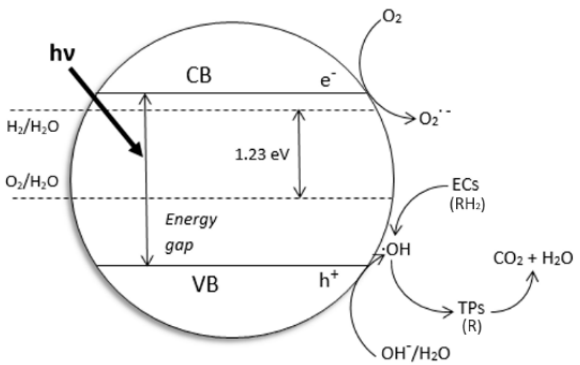
Figure1. MechanismofTiO 2 photocatalysis(ECs—contaminantsofemergingconcern,TPs—transformation Figure 1. Mechanism of TiO 2 photocatalysis (ECs—contaminants of emerging concern, TPs— products, VB—valence band, CB—conduction transformation products, VB—valence band, CB—conduction band)).